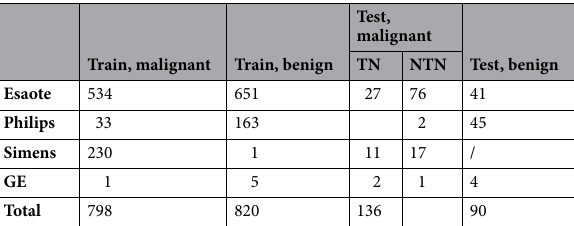
Table 5. Data distribution of ultrasound machines in discrimination of benign from malignant.